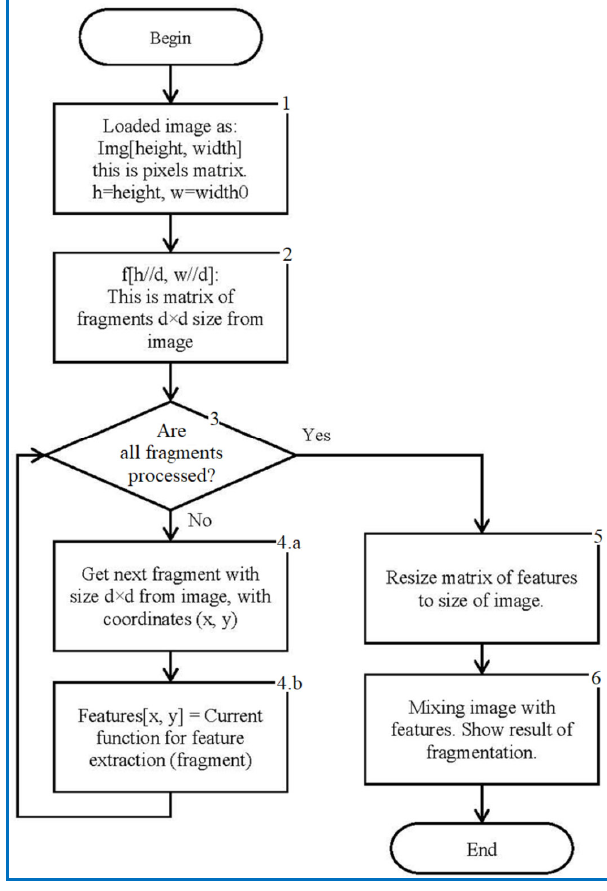
Figure 2. Flowchart for marking the image by texture properties.